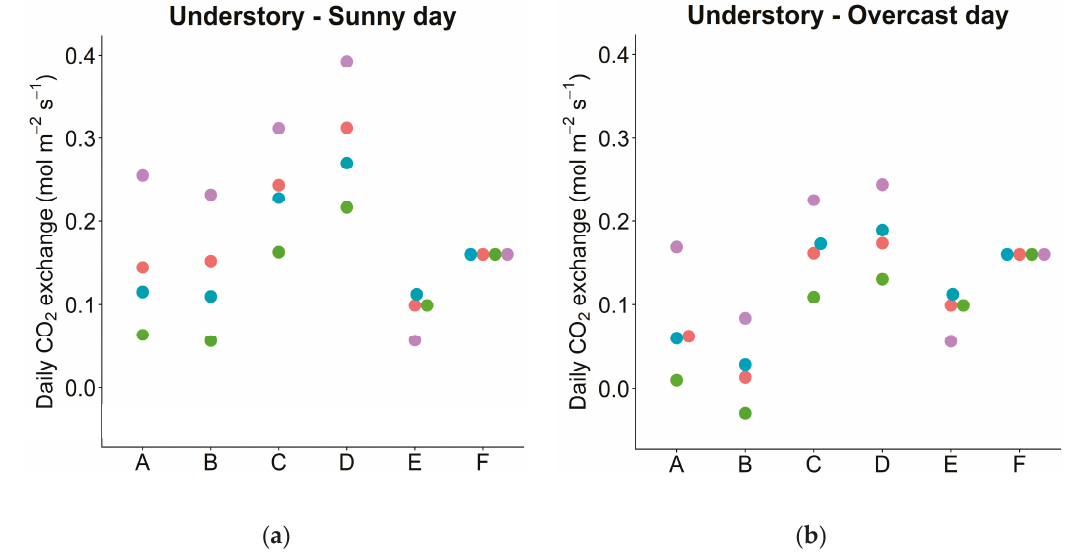
Figure 11. Daily carbon gain per unit area of leaf in the understory on ( a ) a sunny day (3 July 2020) and ( b ) an overcast day (24 June 2020). Results of the same leaf simulated in di ff erent scenarios appear in the same color. A: Estimated actual net photosynthesis. B: Simulated net photosynthesis when the leaves were hypothetically changed to clearing leaves. C: Estimated actual gross photosynthesis. D: Simulated gross photosynthesis when the leaves were changed to the clearing leaves. E: Estimated actual daily respiration. F: Simulated daily respiration when the leaves were changed to the clearing leaves. In simulation F, all four leaves were assumed to have the same respiration rate as the mean value of the clearing